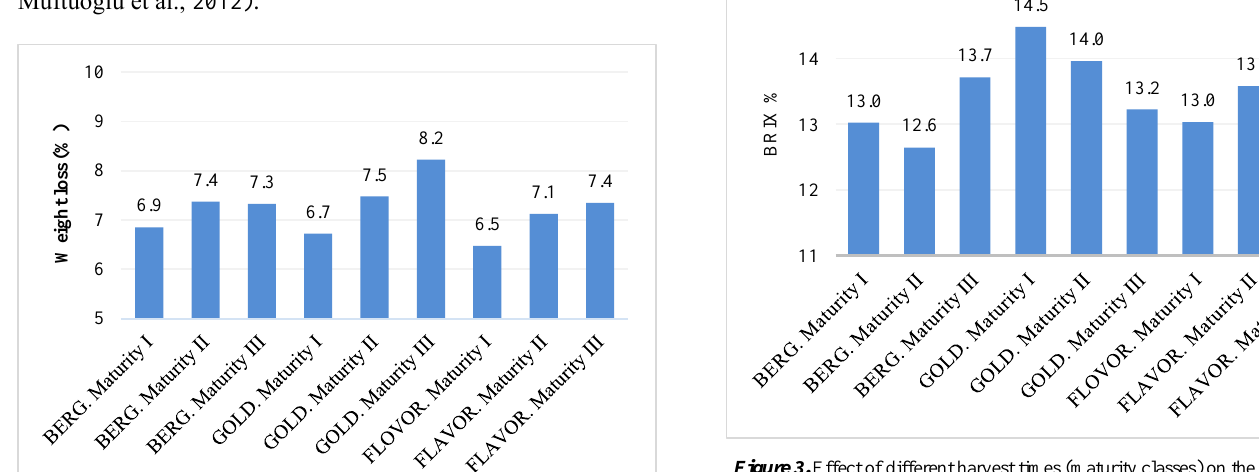
Figure 3. Effect of different harvest times (maturity classes) on the soluble solid content (Brix%) of Bergarouge, Gold Cot and Flavor Cot